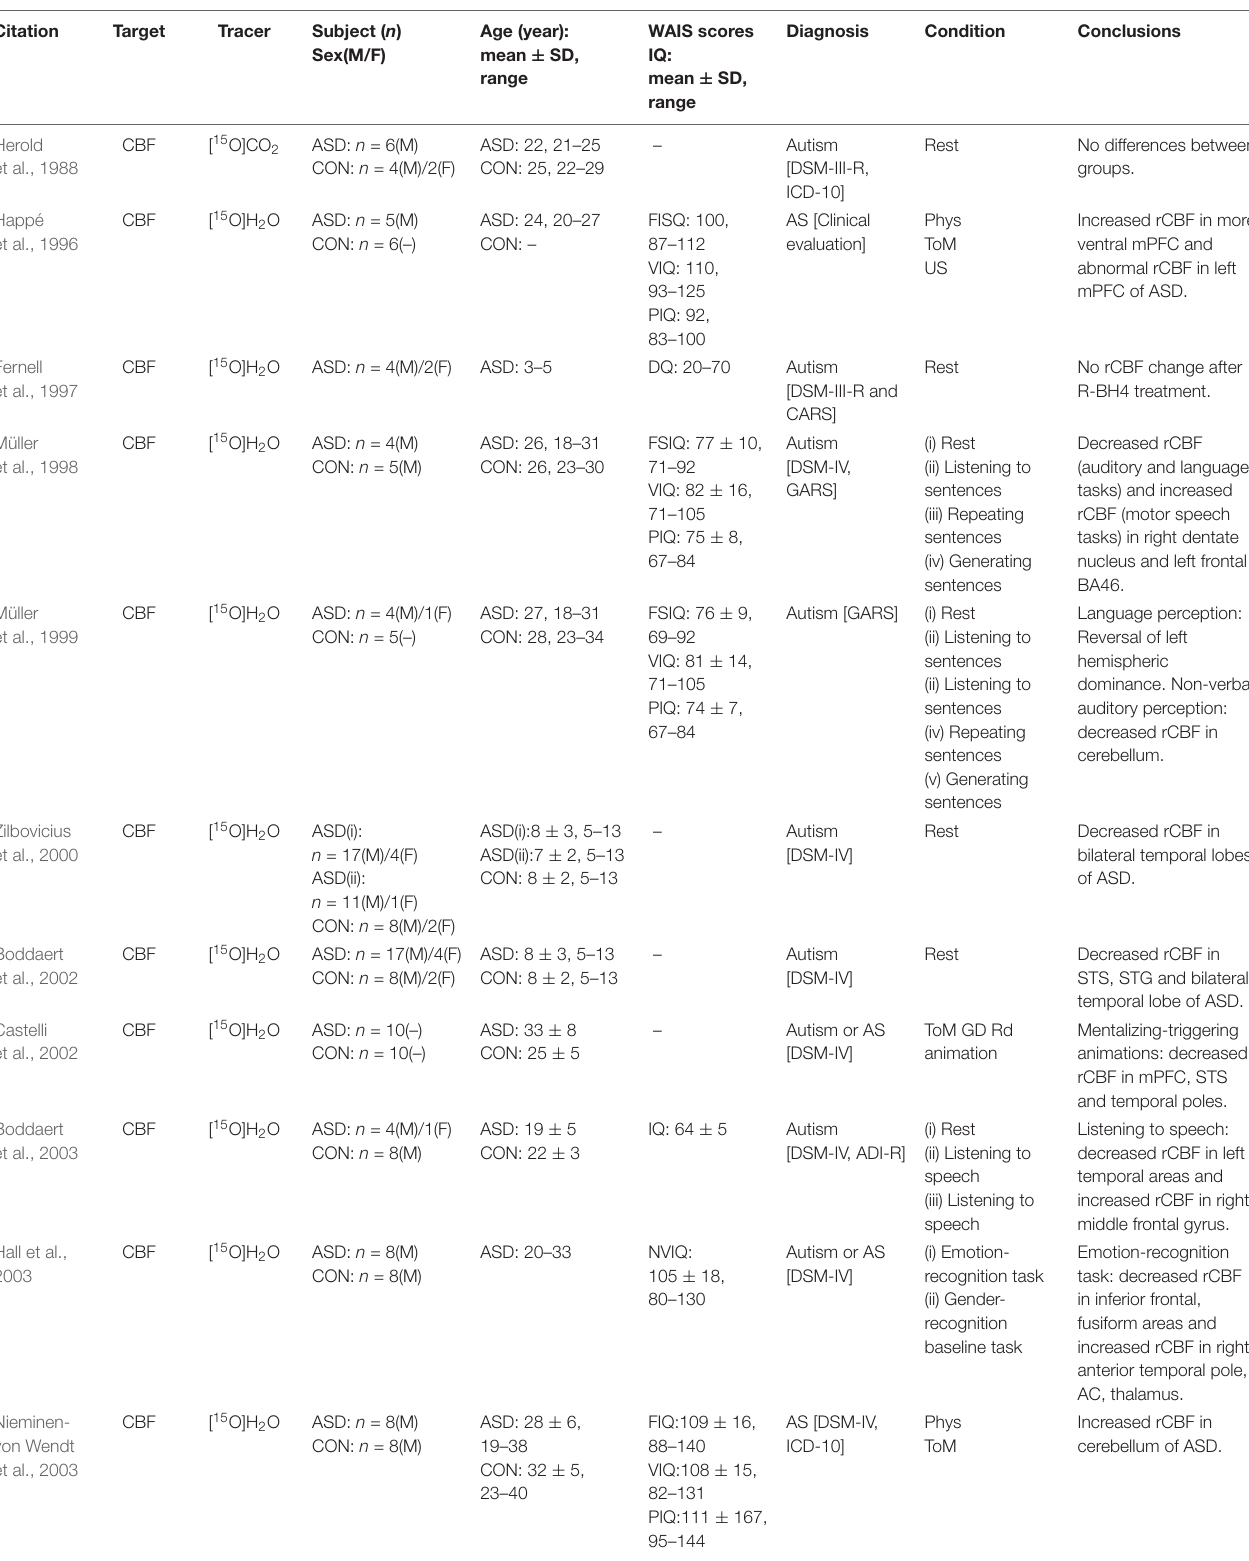
TABLE 3 | CBF PET studies in ASD.